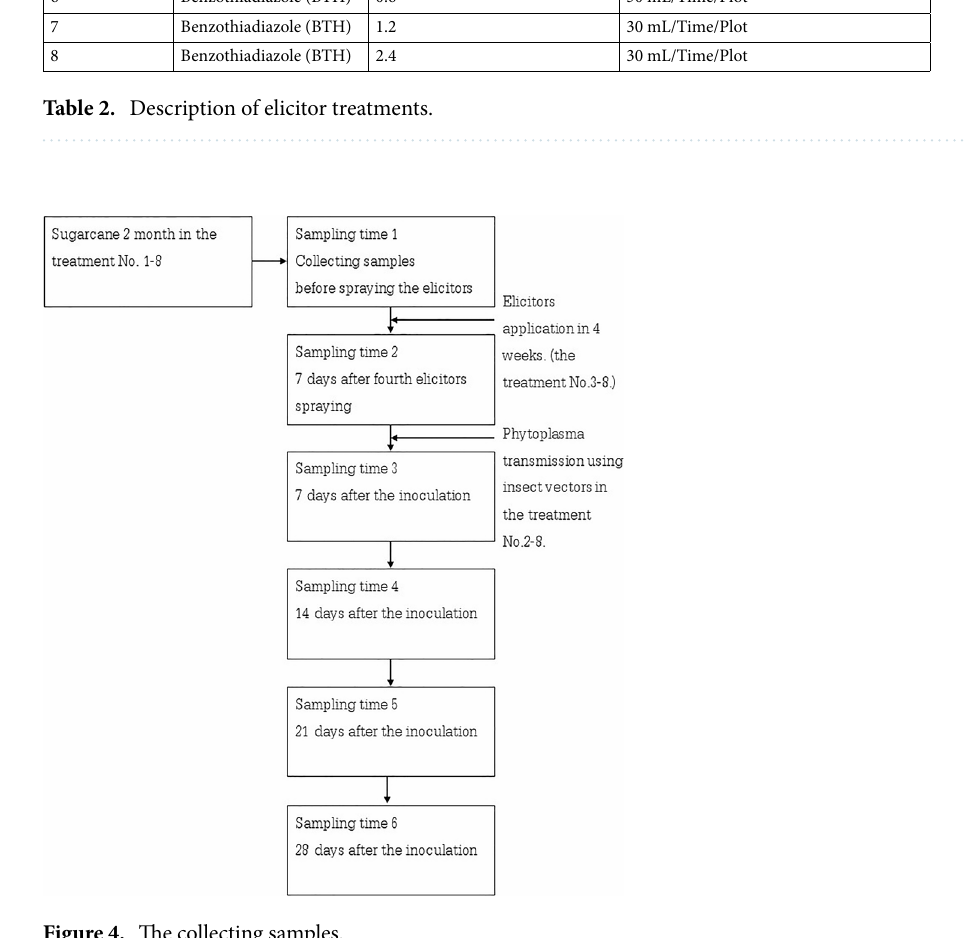
Figure 4. The collecting